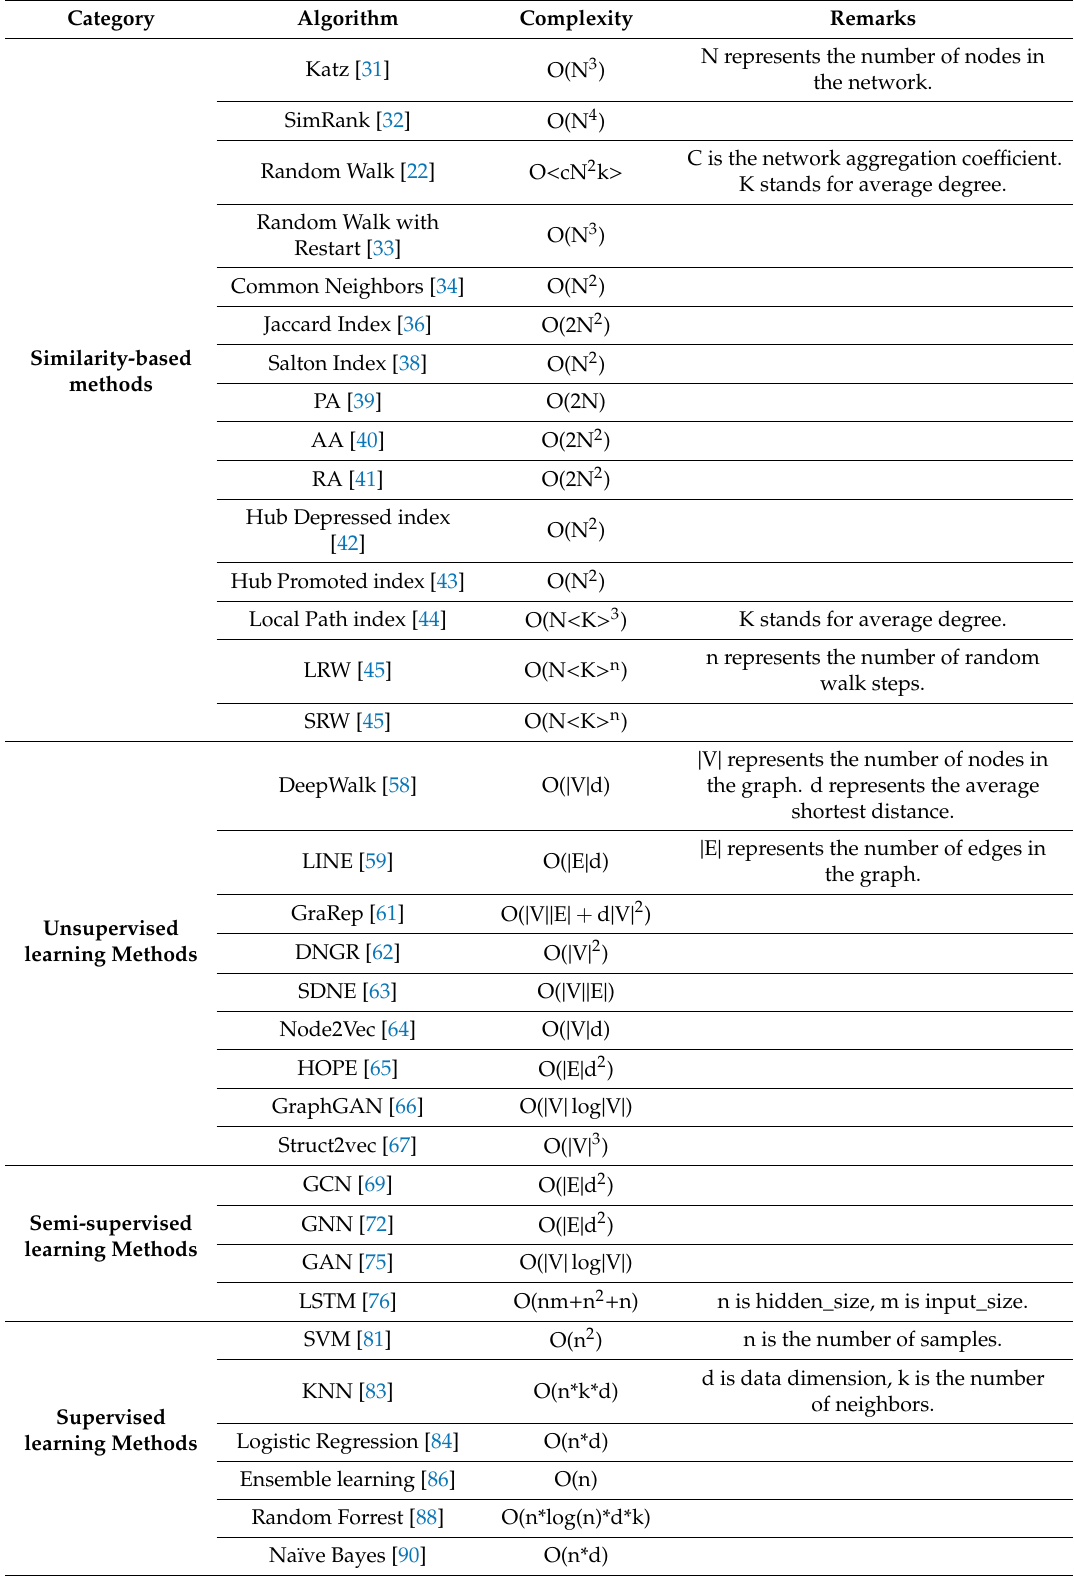
Table 2. Complexity analysis for link prediction